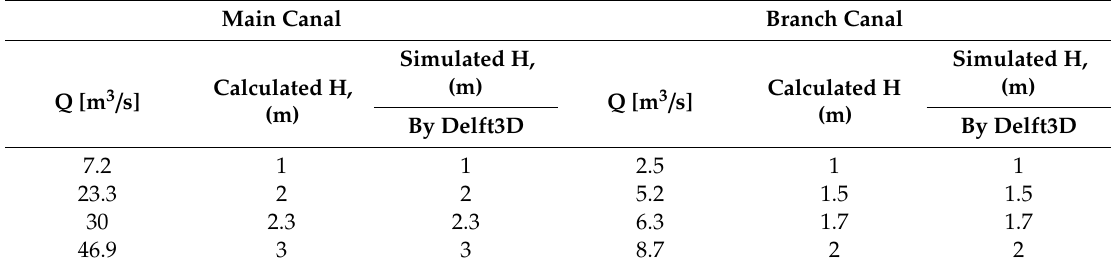
Table 2. Calculated and Simulated water depth for specific discharges for Main and Branch